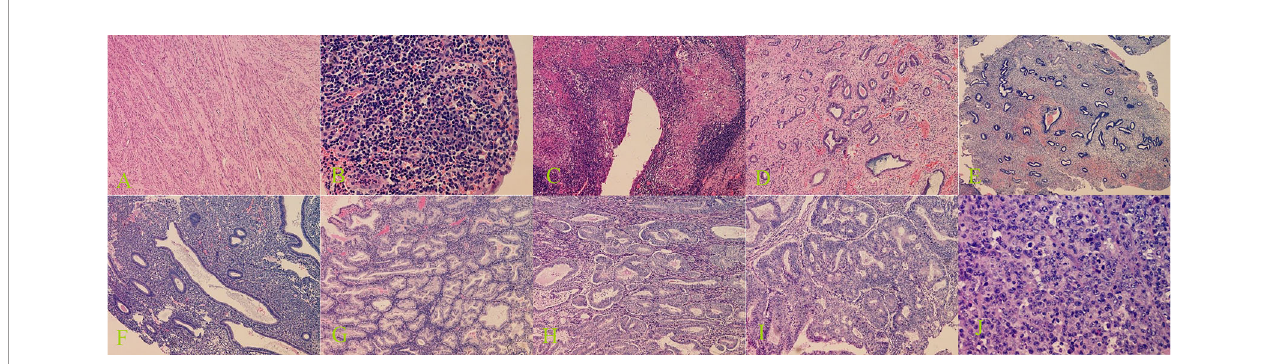
FIGURE 3 | Histopathological examination of benign and malignant lesions of uterine cavity and endometrium. (A) Submucous myomas (100× magni fi cation), (B) endometritis (400× magni fi cation), (C) endometrial tuberculosis (100× magni fi cation), (D) endometrial polyps (100× magni fi cation), (E) endometrial polypoid hyperplasia (40× magni fi cation), (F) endometrial simple hyperplasia (100× magni fi cation), (G) endometrial complex hyperplasia (100× magni fi cation), (H) endometrial complex hyperplasia with atypical hyperplasia (100× magni fi cation), (I) endometrioid adenocarcinoma (100× magni fi cation), and (J) uterine undifferentiated sarcoma (400× magni fi